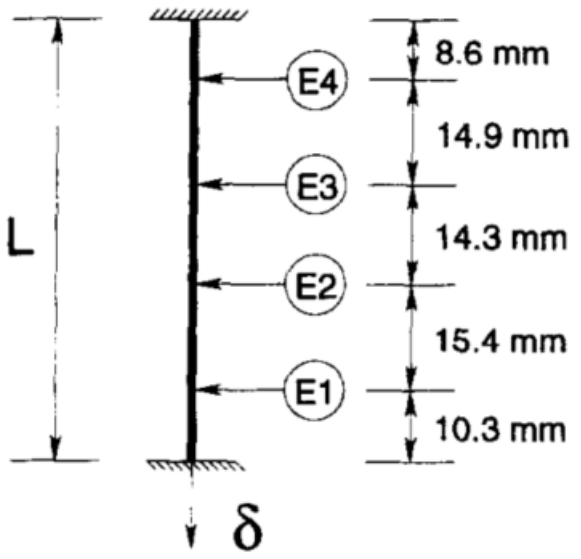
Figure 3. Photograph of a NiTi wire specimen with four extensometers [11]. (Reprinted from Ref. [11], Figure 8, 1995, with permission from Elsevier.)